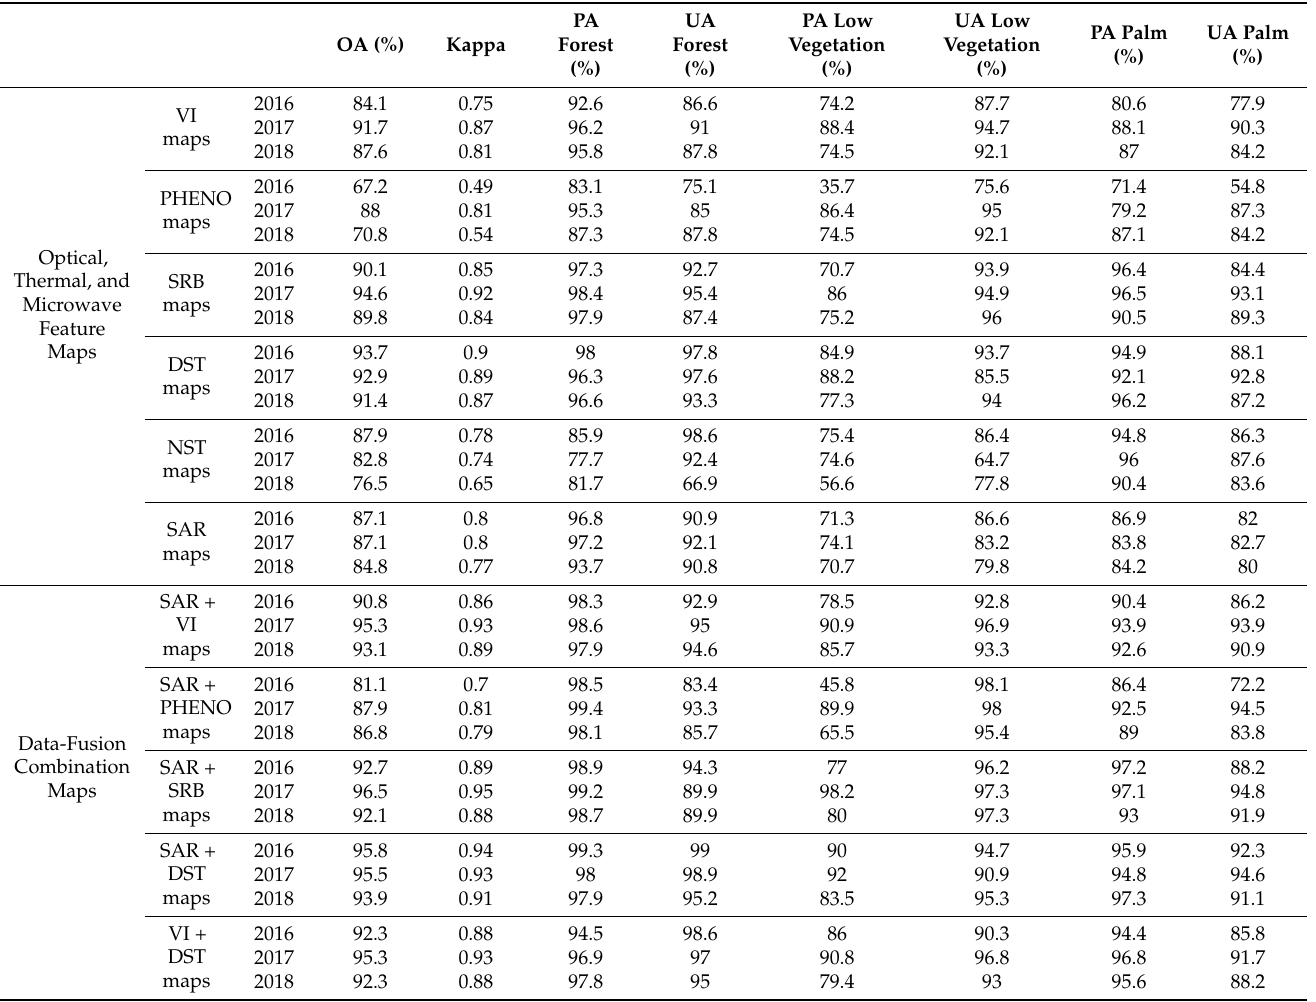
Table 2. Accuracy metrics obtained from each approach across the three years analyzed. The metrics are Overall Accuracy (OA), Kappa coefficient (Kappa), Producer’s Accuracy (PA), and User’s Accuracy (UA). The listed approaches are Vegetation Indices (VIs), Phenology metrics (PHENO), Spectral Reflectance Bands (SRBs), Daytime Surface Temperature (DST), Synthetic Aperture Radar (SAR), and five data-fusion combinations. PA UA Kappa Forest